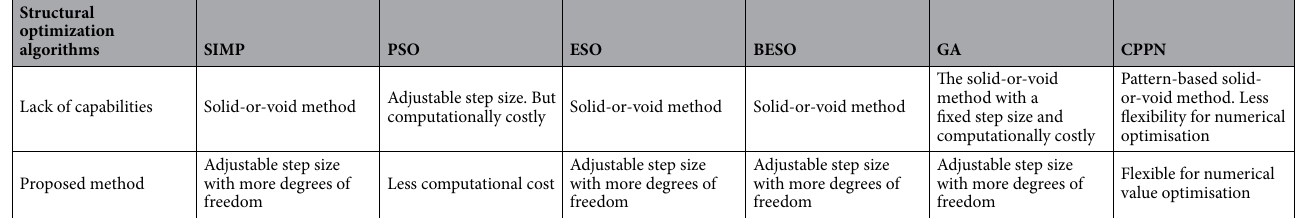
Table 1. A summary of the comparison between the proposed method and other possible optimisation